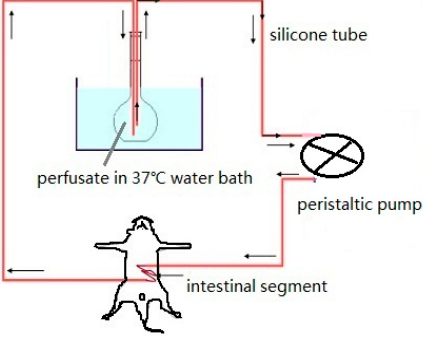
Figure 7. Circular perfusion.